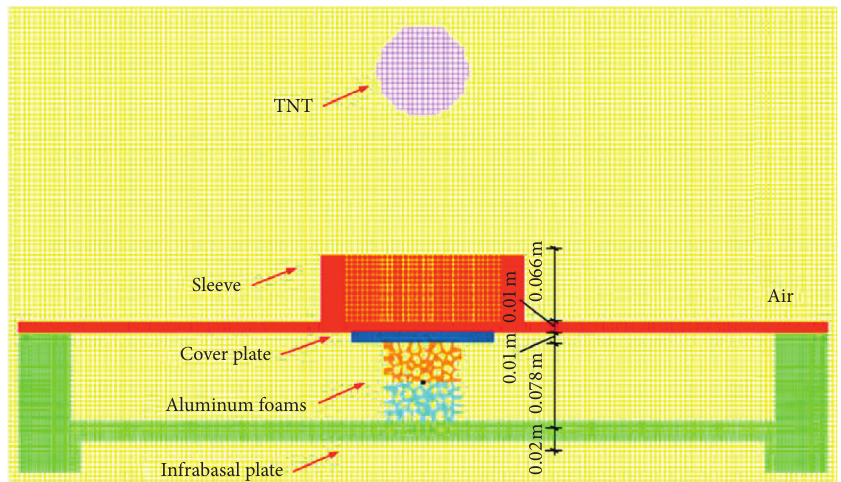
Figure 3: Stress measuring point arrangement.